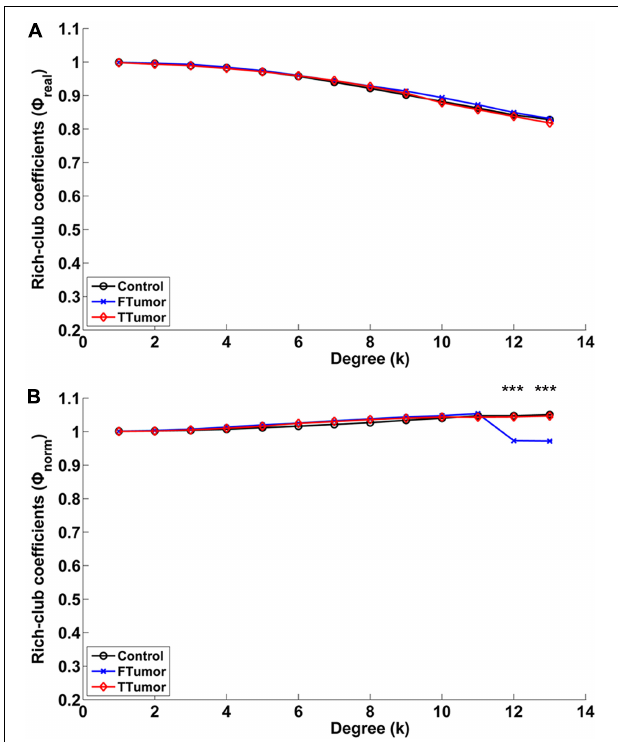
FIGURE 7 | Relationships between rich-club coefficients (real and normalized) and node degrees ( K ) of WM structural networks. (A) Real rich-club coefficients and (B) normalized rich-club coefficients for a range of K s in three groups (node degrees = 13). A rich-club organization phenomenon is considered when normalized rich-club coefficients were larger than 1. FTumors, frontal tumors; TTumors, temporal tumors; WM, white matter. *** P <